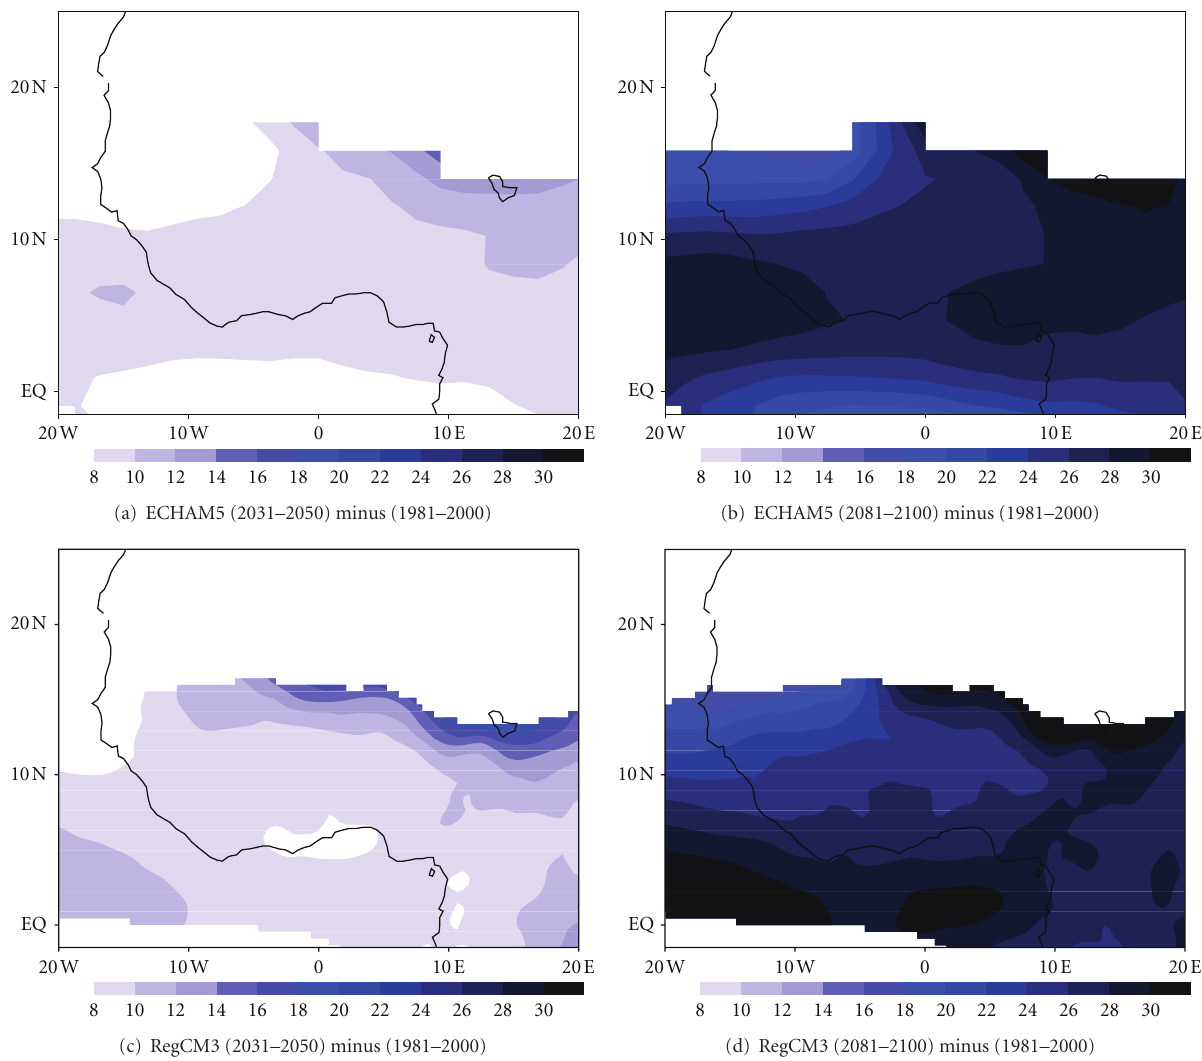
Figure 5: The same as Figure 4 but for precipitable